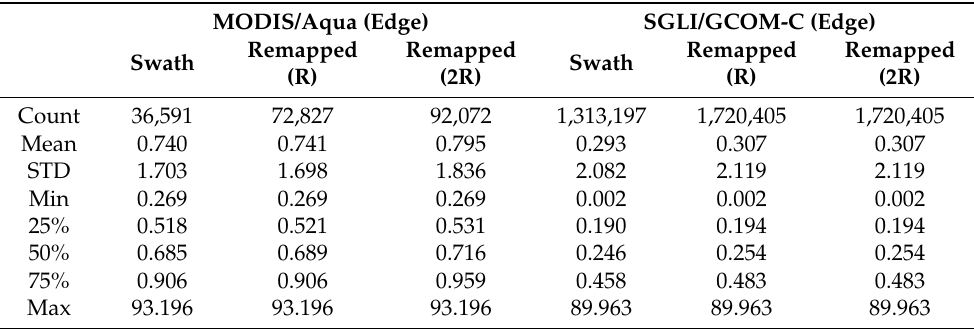
Table 2. Descriptive statistics for the swath and reprojected data in the subset area at the swath edge. The statistics were obtained on log-transformed data and results back-transformed to linear. All data are in mg m –3 except for count, which is the number of pixels in the polygon